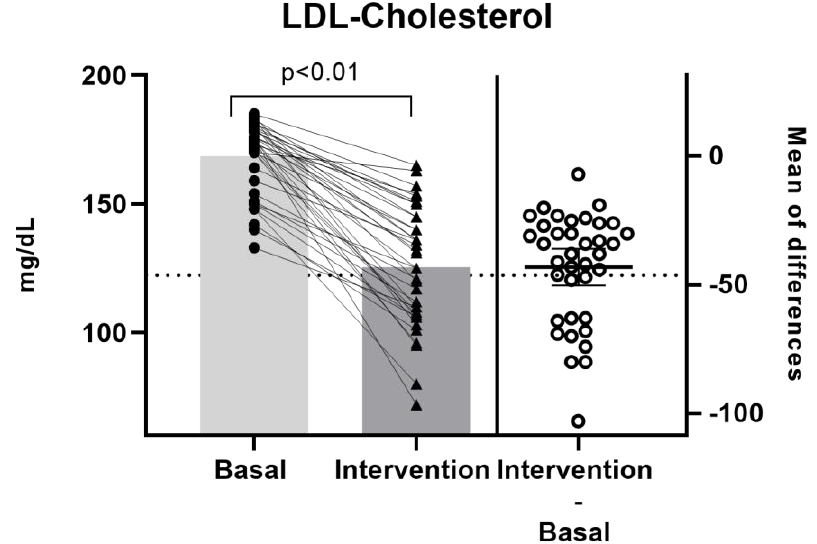
Figure 1. Low-density lipoprotein-cholesterol concentration changes (mg/dL). Baseline (black circles) and after 8 weeks of intervention (black triangles). Scatter plot of means of differences (white circles) with 95% confidence interval (CI). p < 0.01, paired t-test.